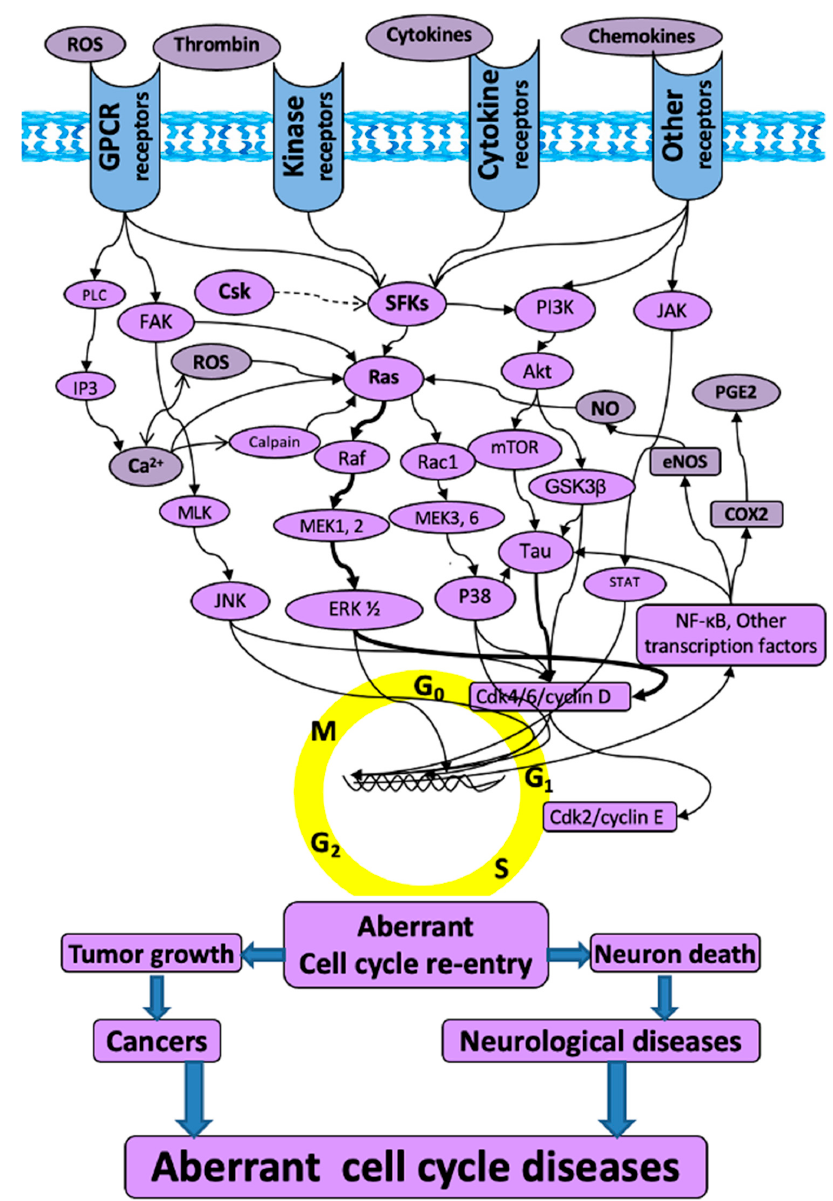
Figure 1. The schematic of “aberrant cell cycle diseases”. The molecules and related mitogenic pathways contributing to the aberrant cell cycle re-entry that is associated with not only tumorigenesis in cancers, but also neuronal death in neurological diseases. The arrows do not necessarily indicate direct binding and/or activation of the downstream molecules; intermediate proteins or kinases may exist. Akt: protein kinase B; Ca2+: calcium; Cdk: cyclin ‐ dependent kinase; COX2: cyclooxygenase ‐ 2;